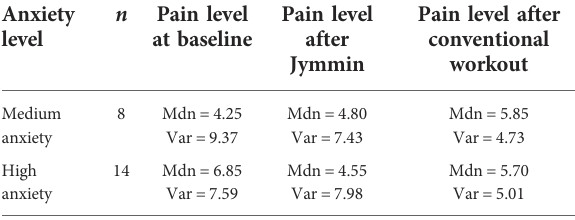
TABLE 1 Descriptive statistics on levels of anxiety and changes in pain